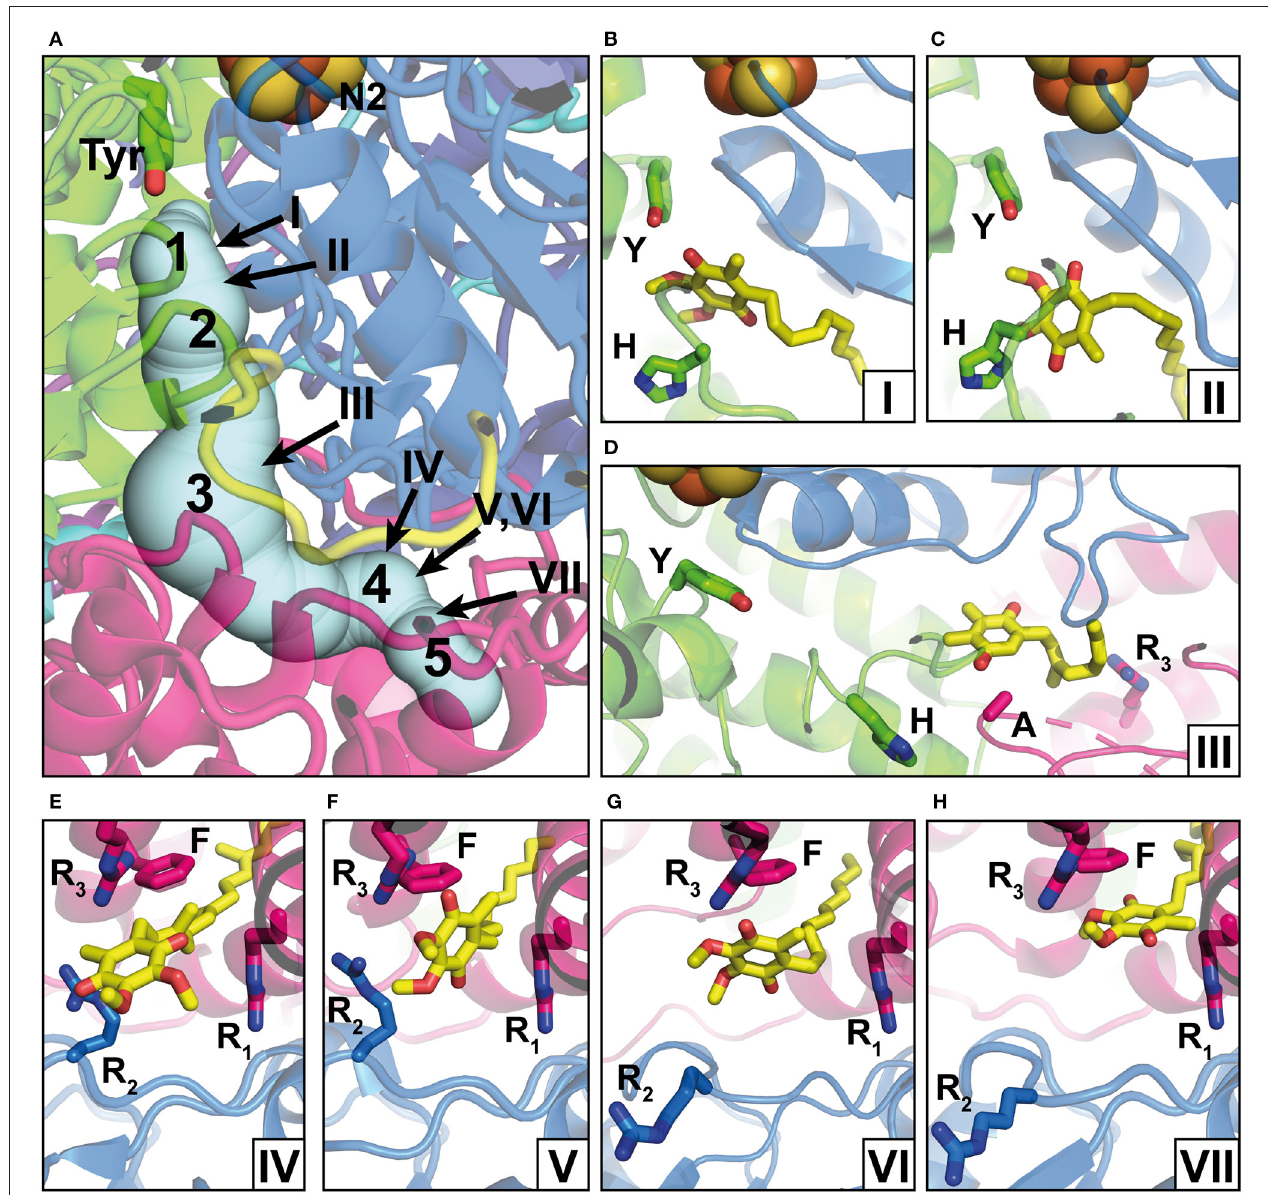
FIGURE 2 | Q binding positions. (A) The Q reduction site in the peripheral arm of complex I (PDB: 6RFR) is formed by subunits NDUFS2 (green) and NDUFS7 (blue). A tunnel for Q access from the membrane traverses subunit ND1 (pink). The tunnel was calculated using the CAVER3 software (Chovancova et al., 2012) (starting point conserved Y144, PDB: 6RFR, probe radius 1.3 Å). Intermediate Q binding positions determined by computational methods are indicated by Arabic numbers according to Haapanen et al. (2019). The positions of Q molecules (head group) modeled into X-ray or cryo-EM structures are indicated by Roman numbers and are shown in detailed views in separate panels; the direction of view is consistent for panels in the same row. (B) DBQ bound to complex I from T. thermophilus (PDB: 6I0D) (Y, Y87; H, H38); (C) DBQ bound to complex I from Ovis aries in the closed state during turnover (PDB: 6ZKC) (Y, Y108; H, H59); (D) PL9 bound to ndh complex I from T. elongatus BP-1 (PDB: 6KHJ) (Y, Y72; H, H23; A, A237; R 3 , R329); (E) Q9 bound to complex I from Y. lipolytica (PDB: 6RFR) (R 1 , R27; R 2 , R108, R 3 , R297; F, F228); (F) DBQ bound to complex I from O. aries in the closed state during turnover (PDB: 6ZKC) (R 1 , R25; R 2 , R77, R 3 , R274; F, F224); (G) DBQ bound to complex I from O. aries in the open state with NADH bound in the N module (PDB 6ZKH) (R 1 , R25; R 2 , R77, R 3 , R274; F, F224); (H) DBQ bound to complex I from O. aries in the open state during turnover (PDB 6ZKD) (R 1 , R25; R 2 , R77, R 3 , R274; F,